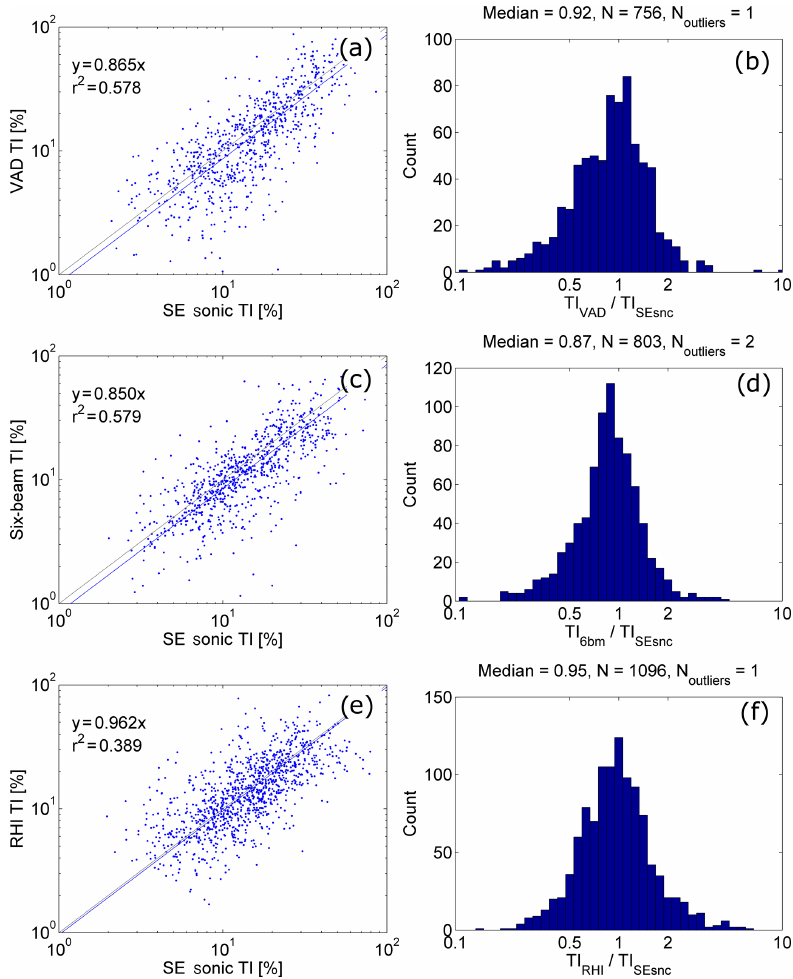
Figure 9. Same as Fig. 5 but for TI instead of TKE. Lidar measurements are from TKE from two- φ (a, b) , the six-beam technique (c, d) , and the RHI scans (e, f)